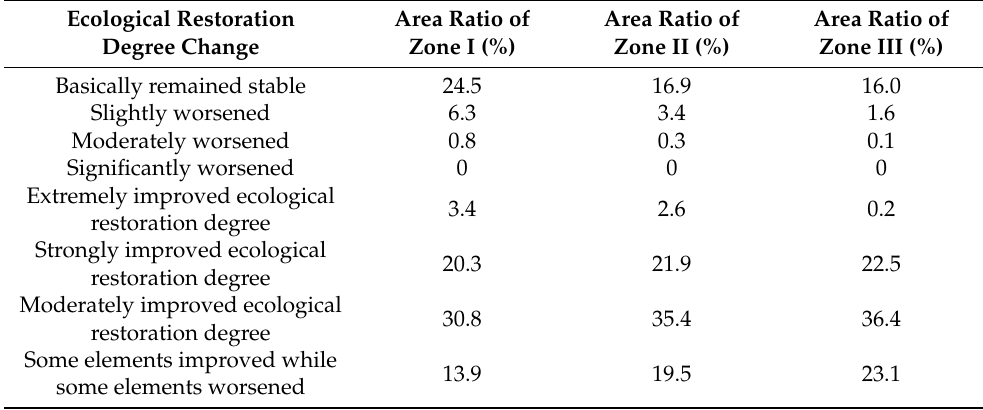
Table 7. Contribution rates of human activities and climate factors to NPP and soil erosion modulus changes from 2000 to 2019.